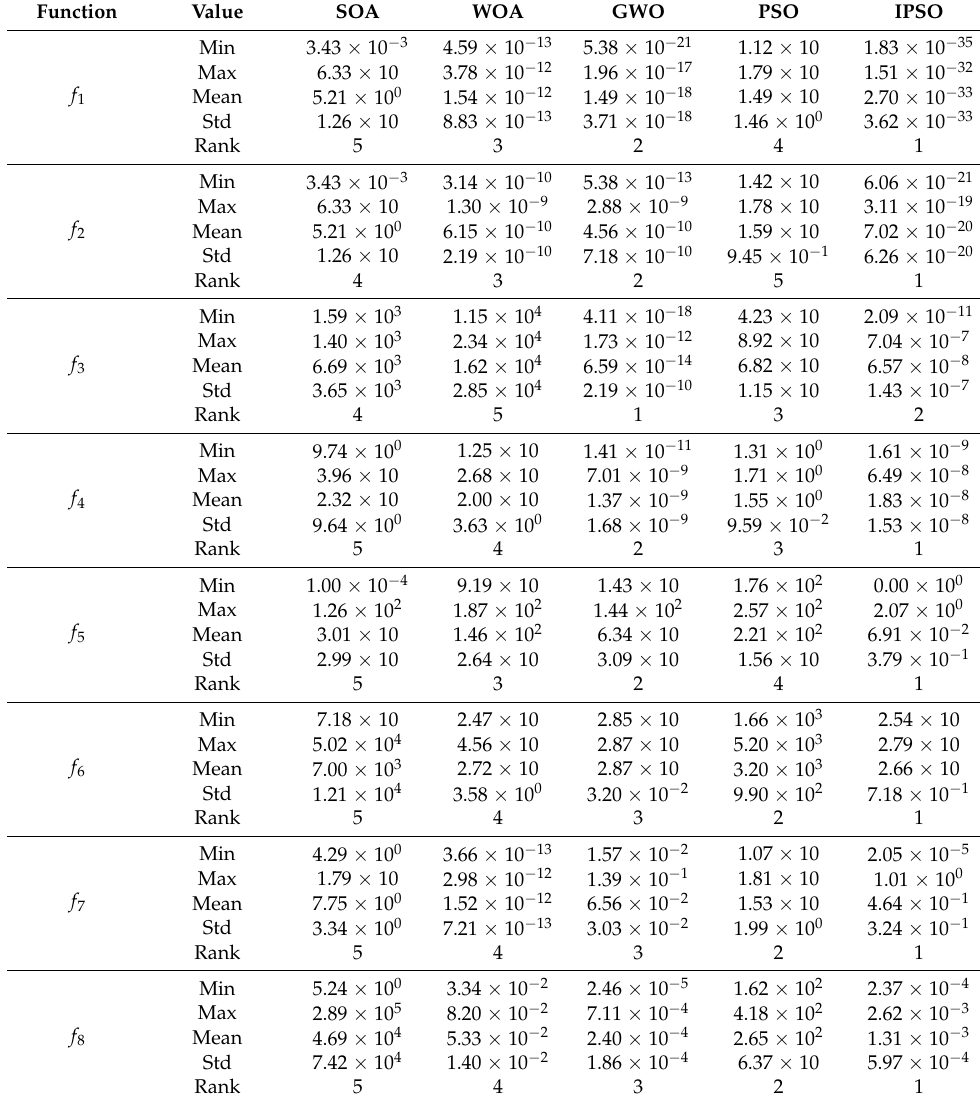
Table 2. Comparison results between IPSO and other evolutionary algorithms. Function Value SOA